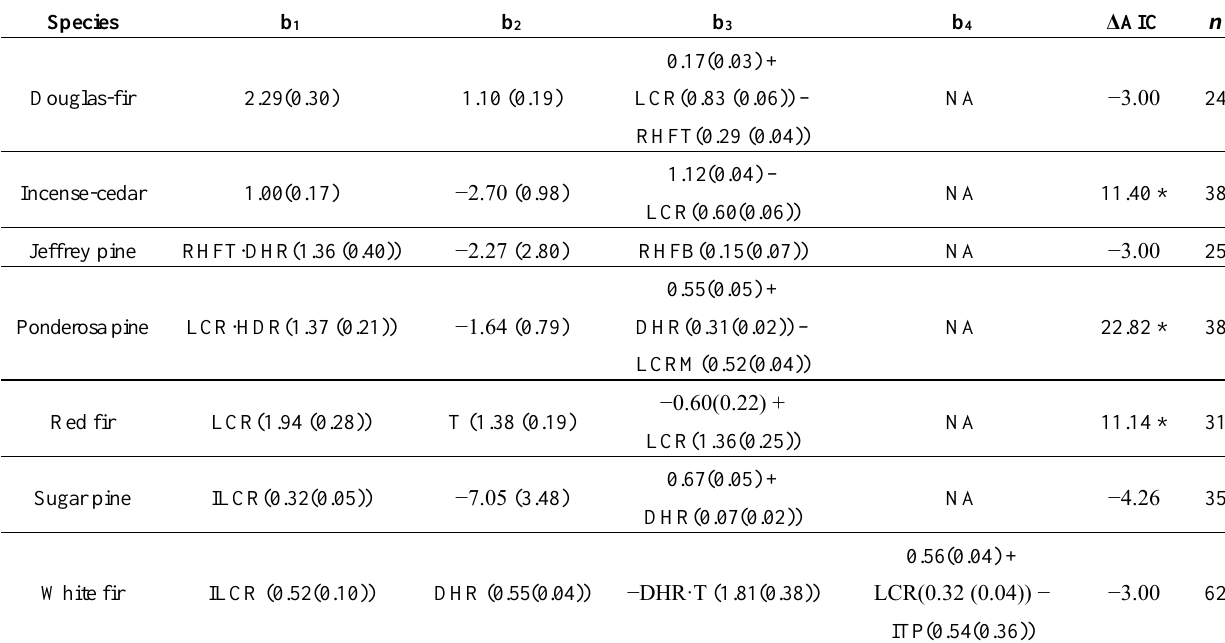
Table 6. Summary of model parameter estimates for crown portion leaf area by